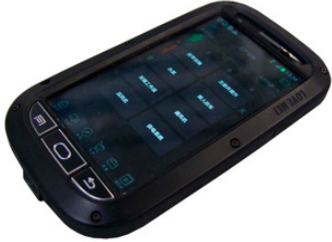
Figure 8. The intrinsic safety mobile phone.